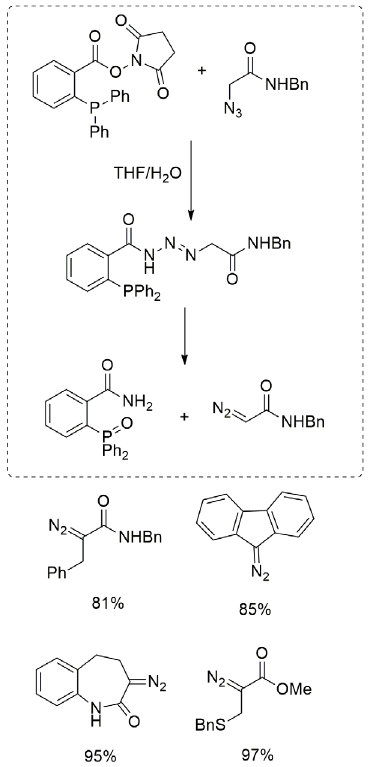
Figure 43 - Conversion reaction of organoazides to diazo compounds mediated by